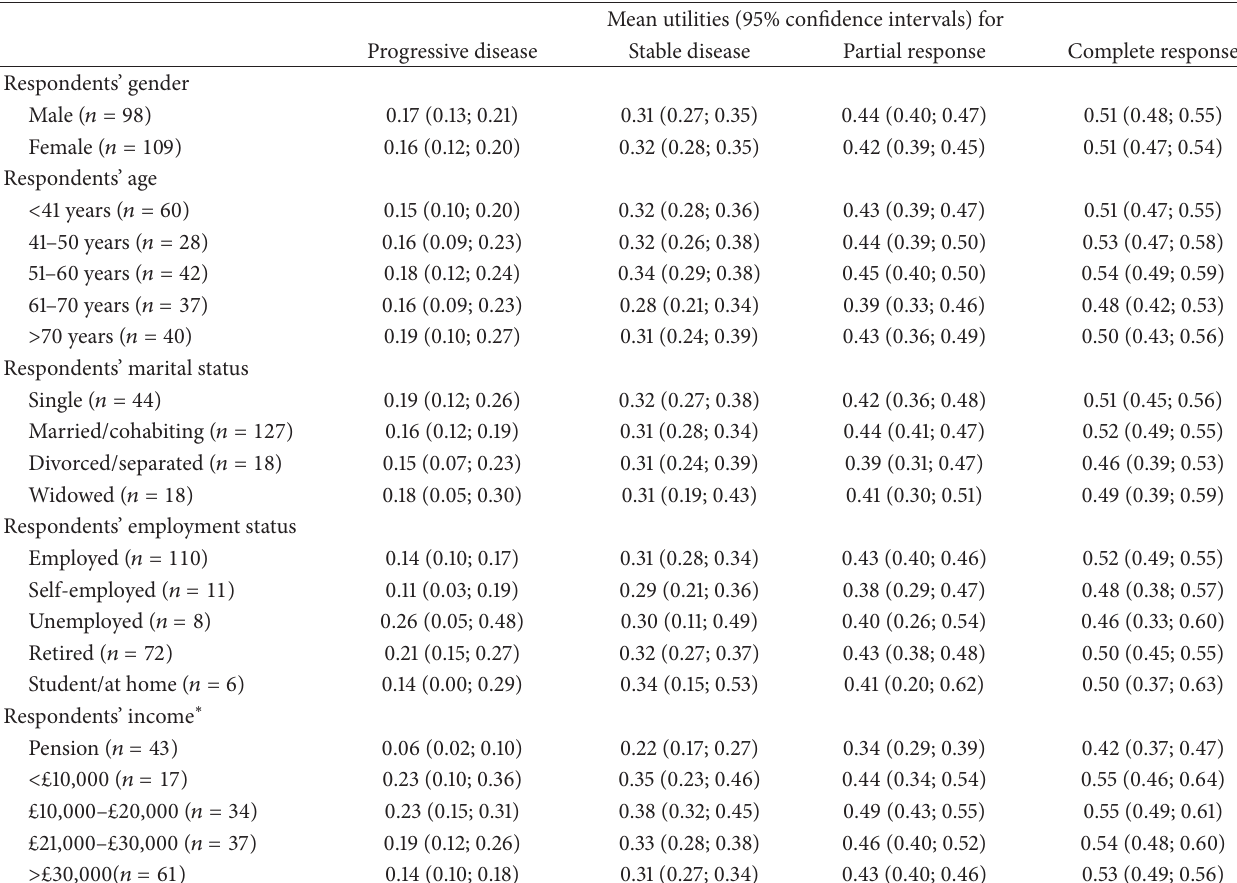
Table 5: Mean utilities (95% confidence intervals) for ASTS health states, stratified by socio-demographic parameters, using SG. ( ∗ 15 respondents refused to provide details about their